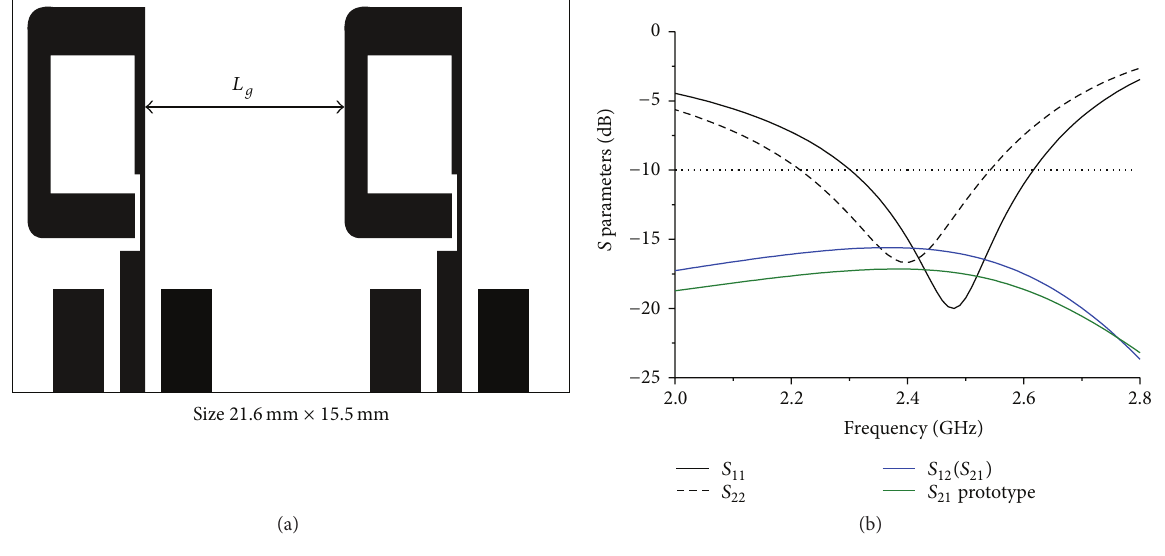
Figure 6: (a) MIMO antenna system Type II, (b) 𝑆 parameters of Type II.